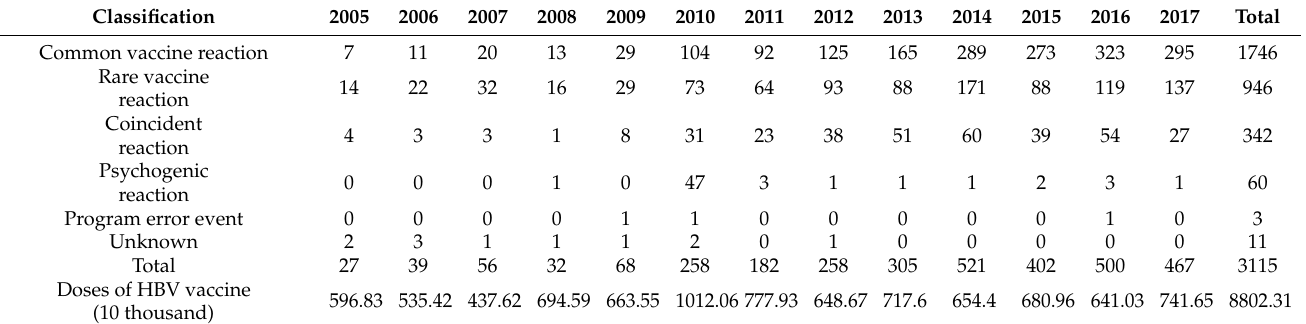
Table 1. Number of AEFI cases related to HBV vaccination in Guangdong Province from 2005 to